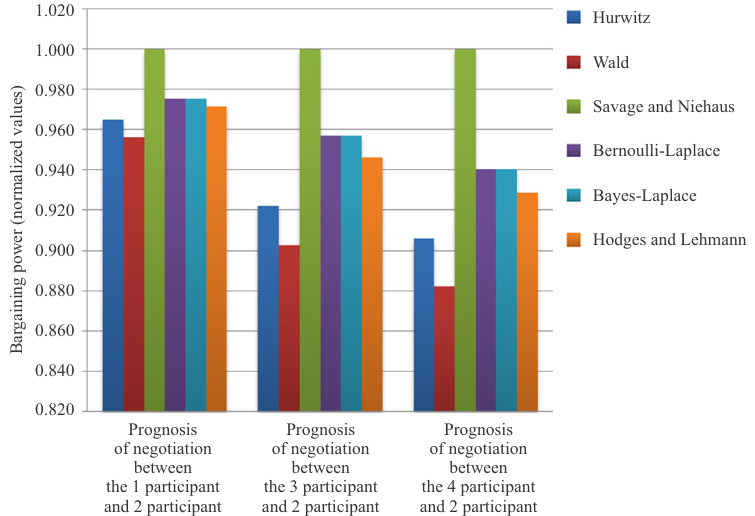
Fig. 2. The distribution of the negotiation payoffs in attracting investments according to different optimisation